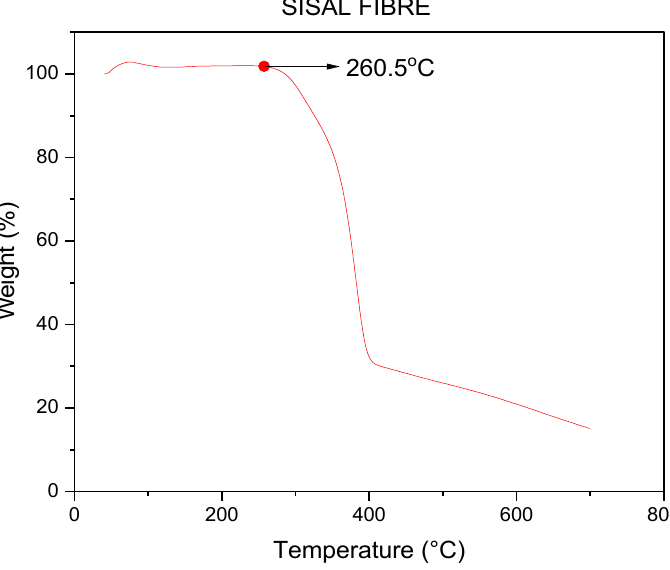
Figure 7. TGA result of sisal fiber.